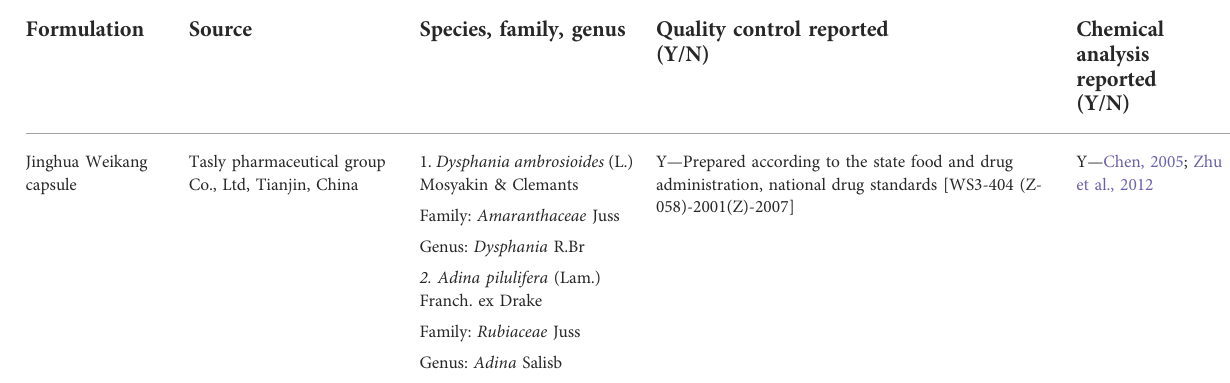
TABLE 1 Main components of the Jinghua Weikang